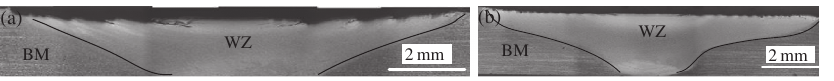
Figure 3: Cross-section morphologies: (a) 1.8mm/120 rpm/30mm/min and (b) 2.5mm/100 rpm/30mm/min.